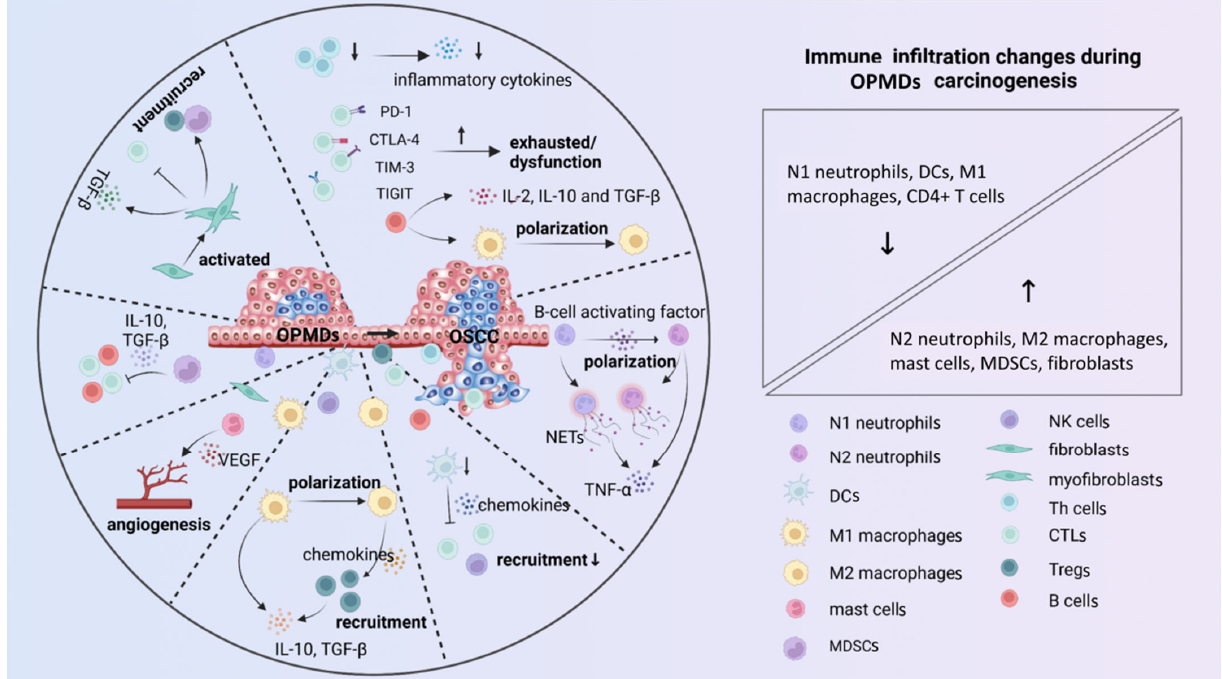
Figure 1. The immunosuppressive microenvironment gradually develops as OPMDs progress. The infiltration of immune cells changes with the progression of OPMDs (right panel). The immune cells convert toward inhibitory phenotypes (N2 neutrophils and M2 macrophages), produce anti- inflammatory mediators (NETs, IL-10, TGF- β , and IL-2), and recruit immunosuppressive cells (Tregs and MDSCs) that favor potentially malignant cells capable of immune evasion. Furthermore, increased angiogenesis mediated by VEGF accelerates the carcinogenesis process. Pointed arrows mean “promote” and blunt-end arrows mean “inhibit”. The upward arrows “ ↑ ” indicate “increase”, and downward arrows “ ↓ ” indicate “decrease”. NETs, neutrophil extracellular trap; TNF- α , tumor necrosis factor- α ; IL-10, interleukin-10; TGF- β , transforming growth factor- β ; PD-1, programmed cell death protein-1; CTLA-4, cytotoxic T-lymphocyte antigen-4; TIM-3, T cell immunoglobulin, and mucin domain-containing protein-3; TIGIT, Ig and ITIM domains; VEGF, vascular endothelial growth